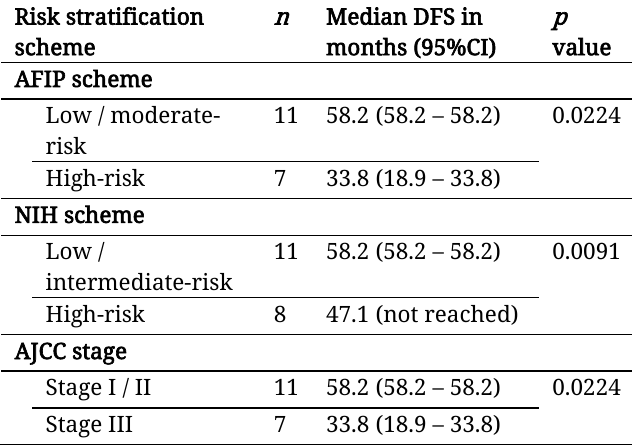
Table 4: DFS of high-risk groups compared to other risk categories using 3 risk stratification schemes